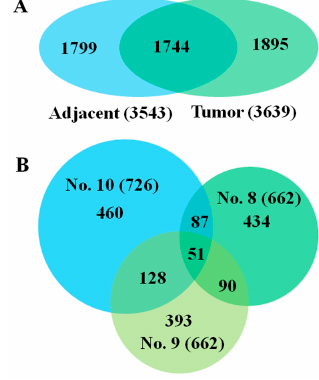
Figure 1. Venn diagrams of total identified proteins and dysregulated proteins. ( A ) Total proteins identified from three cases in tumor or adjacent tissues respectively. One thousand seven hundred forty-four proteins identified appear in both tumor and adjacent tissues; ( B ) The number of proteins with more than twofold differential expression in three cases, respectively, and the number of proteins shared in two or three cases.